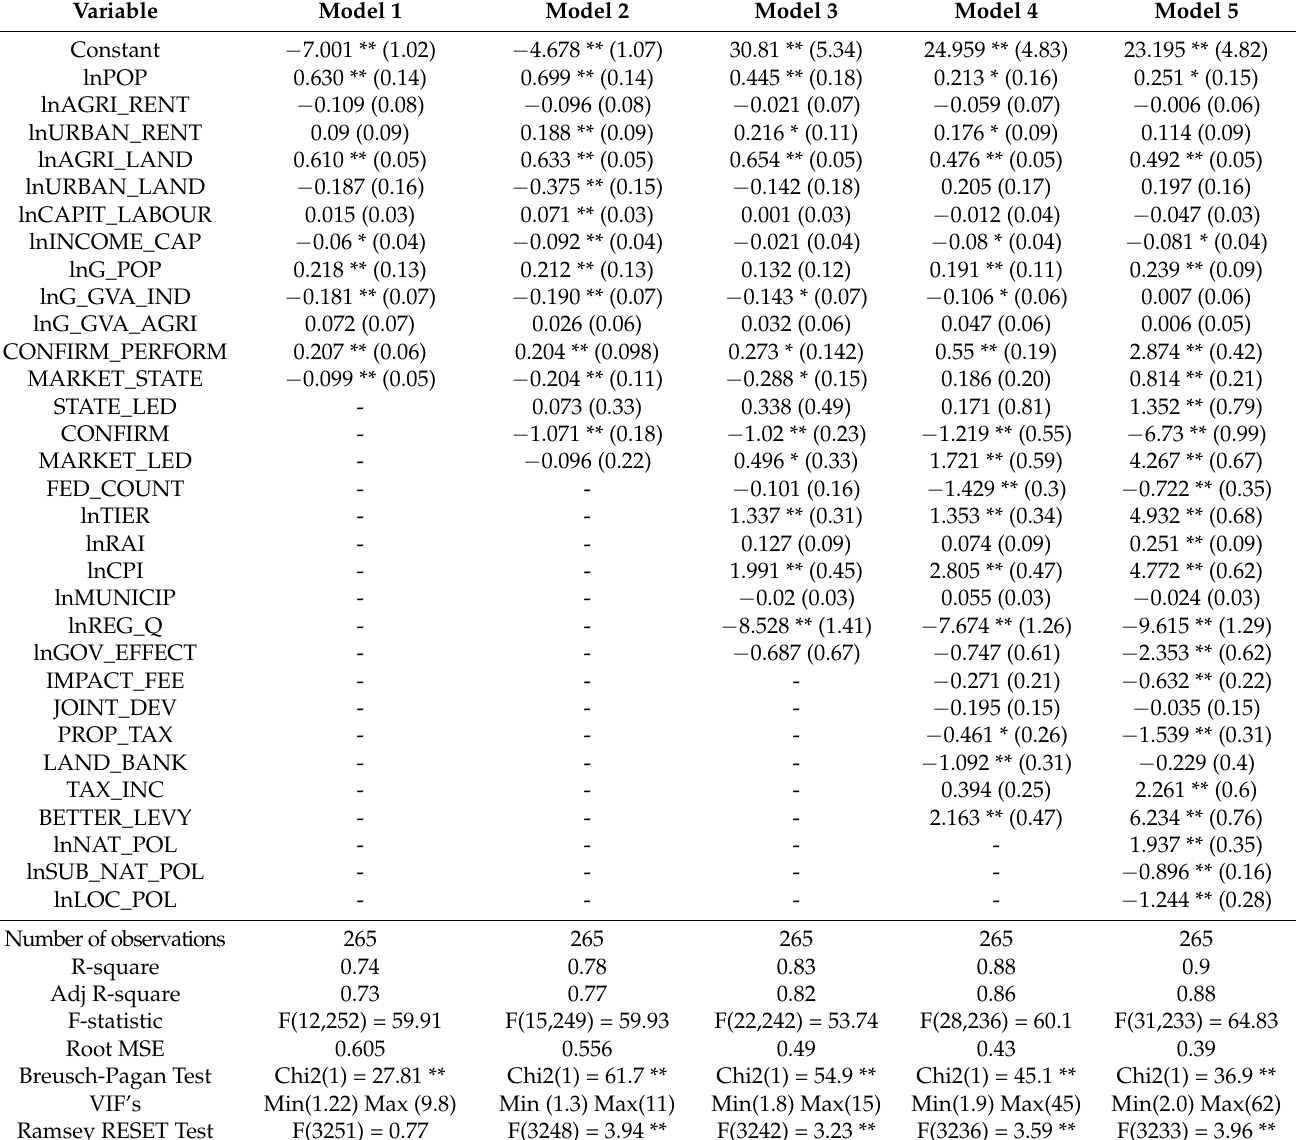
Table notes: * Statistically significant p -value ( p < 0.10 or p < 0.05). In parenthesis are standard errors regarding the coefficients; VIF is the Variance Inflation